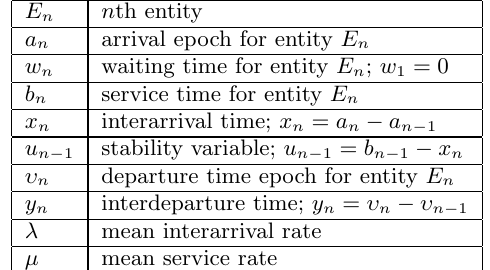
Table 1: Notation for the Single Server